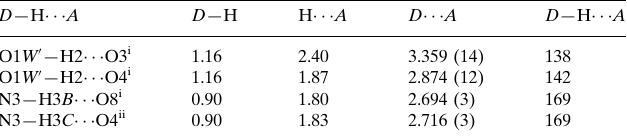
Hydrogen-bond geometry (A˚ , (cid:2)